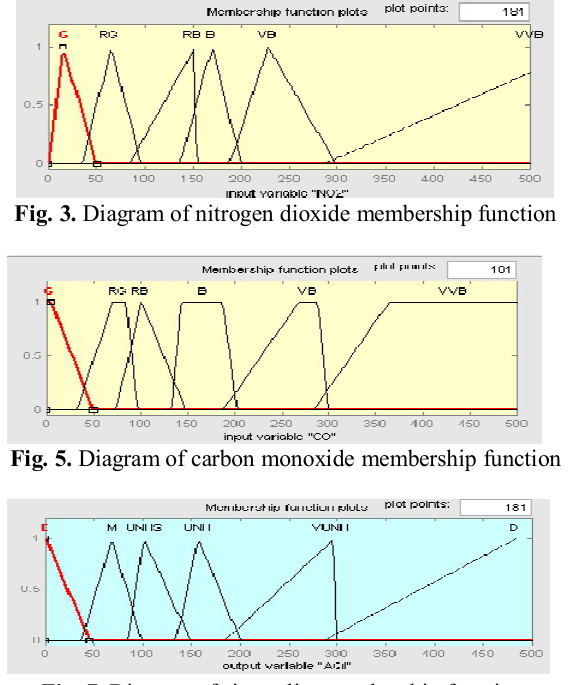
Fig. 6. Diagram of air particles membership function Fig. 7. Diagram of air quality membership